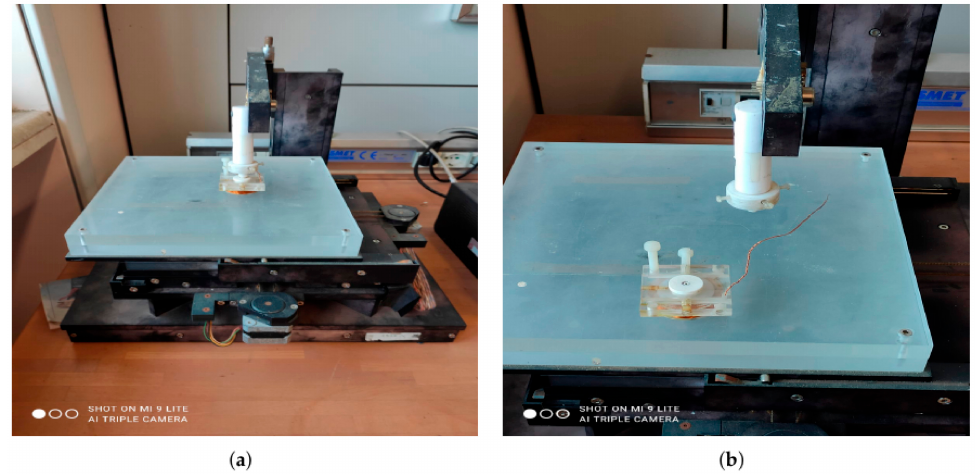
Figure 7. ( a ) The manufactured probe, mounted on a handling system to scan the CFRP plate; ( b ) its construction